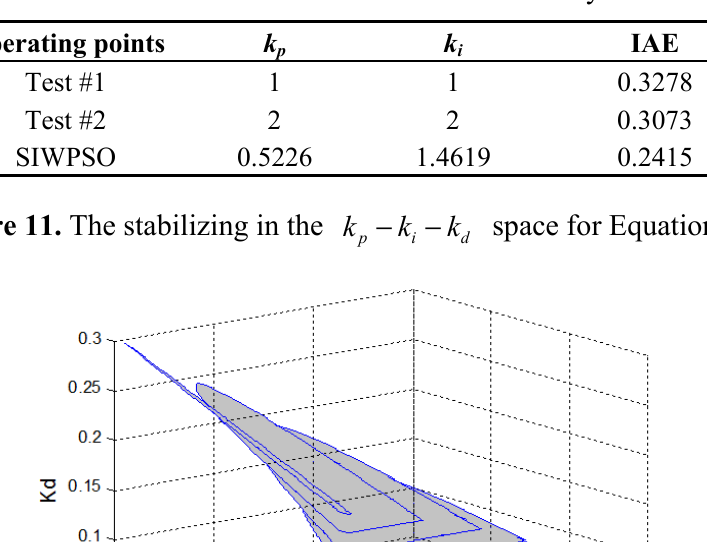
Table 6. The IAE values for the drive train system.